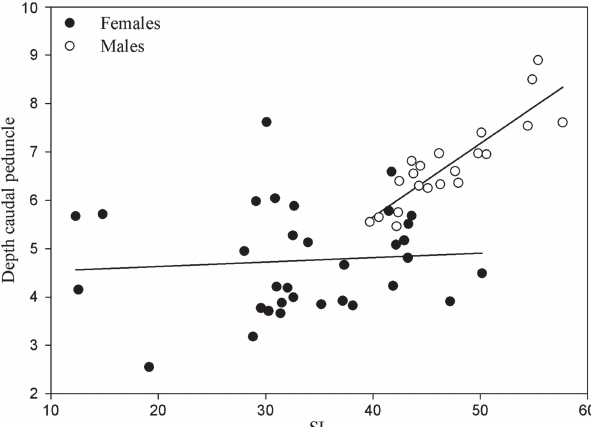
Fig. 3. Scatterplot of caudal peduncle depth versus SL in males and females of Pyrrhulina capim , new species. Lines represent the 95% confidence intervals.